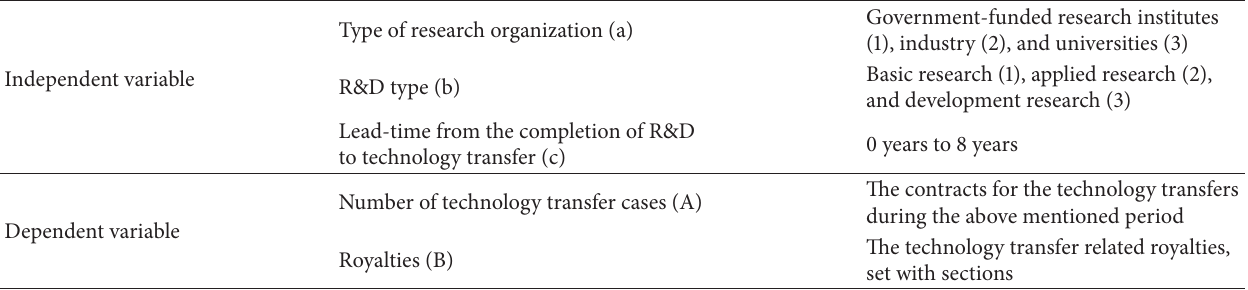
Table 2: The categories of the variables and the